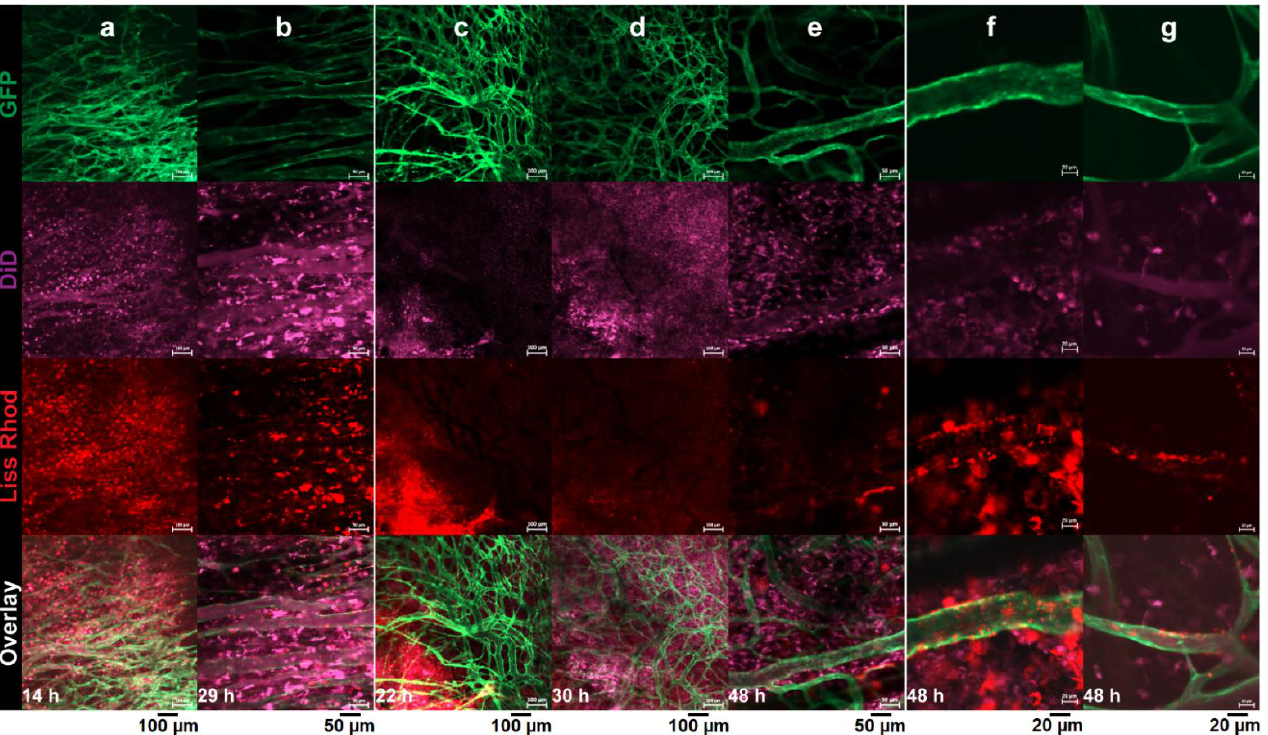
Figure 4. Intravital microscopy imaging of intratumoral behavior of Rho-PE-labeled (red) RGD-liposomes (R3-FPL) and DiD-labeled (purple) TAT-liposomes (T2-FPL) inside B16F0 tumors using the dorsal skin-fold chamber. While in some regions both liposomes exhibit almost identical cellular association ( a , b ), in some regions extravasated T2-FPL interacts more than extravasated R3-FPL with cells ( c – e ), while it is R3-FPL that can be seen associated with tumor vasculature ( f , g ). Mice were co- injected with 5 μmol of each liposomal preparation and images were captured at different time points after injection. Green fluorescence of endothelial cells due to eNOStag-GFP expression.